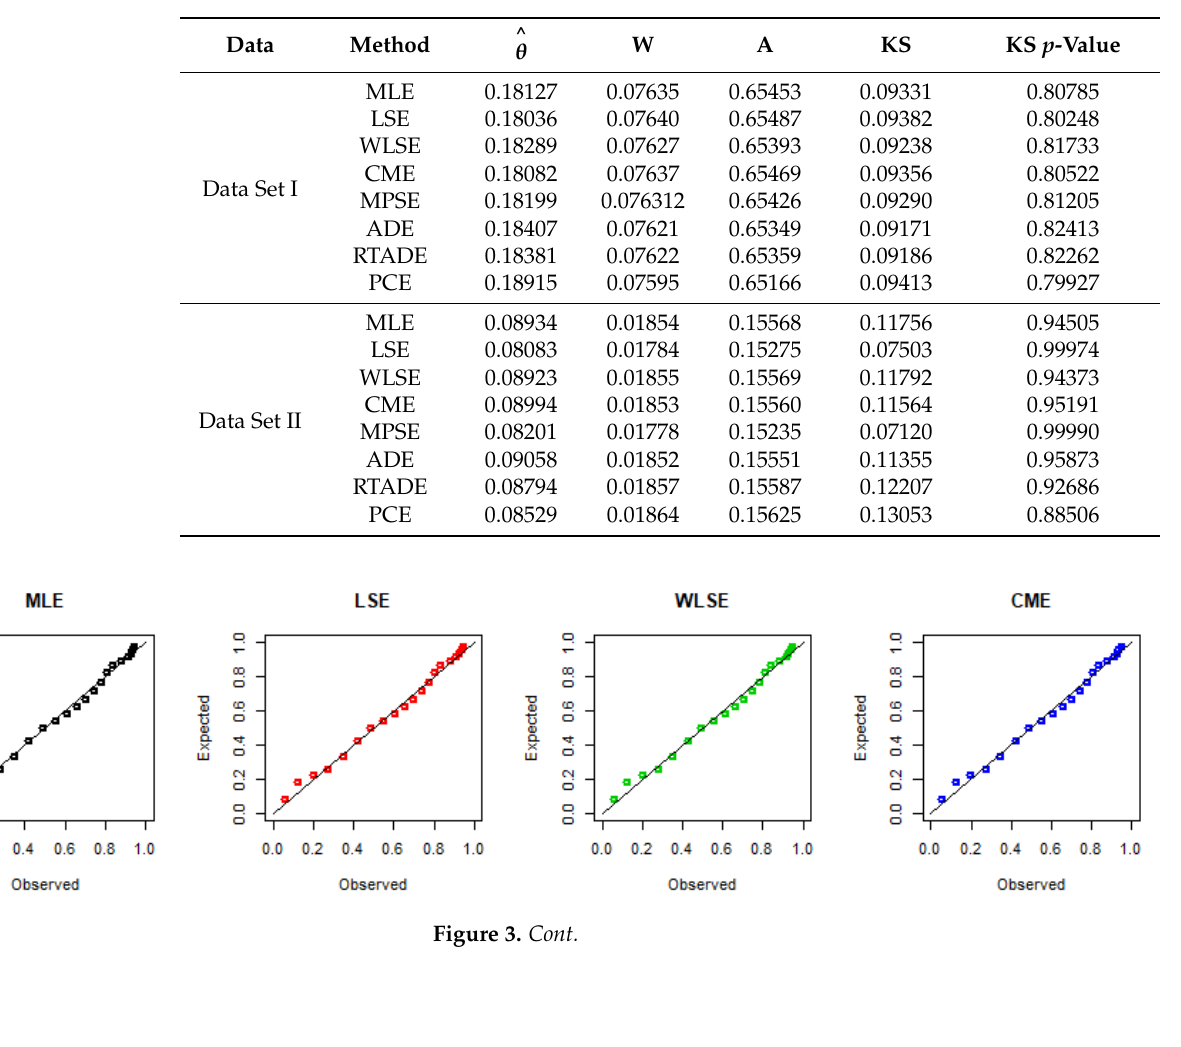
Figure 3. PP plots for COVID-19 data using the eight estimates. Figure 4. PP plots for remission times data using the eight estimates.